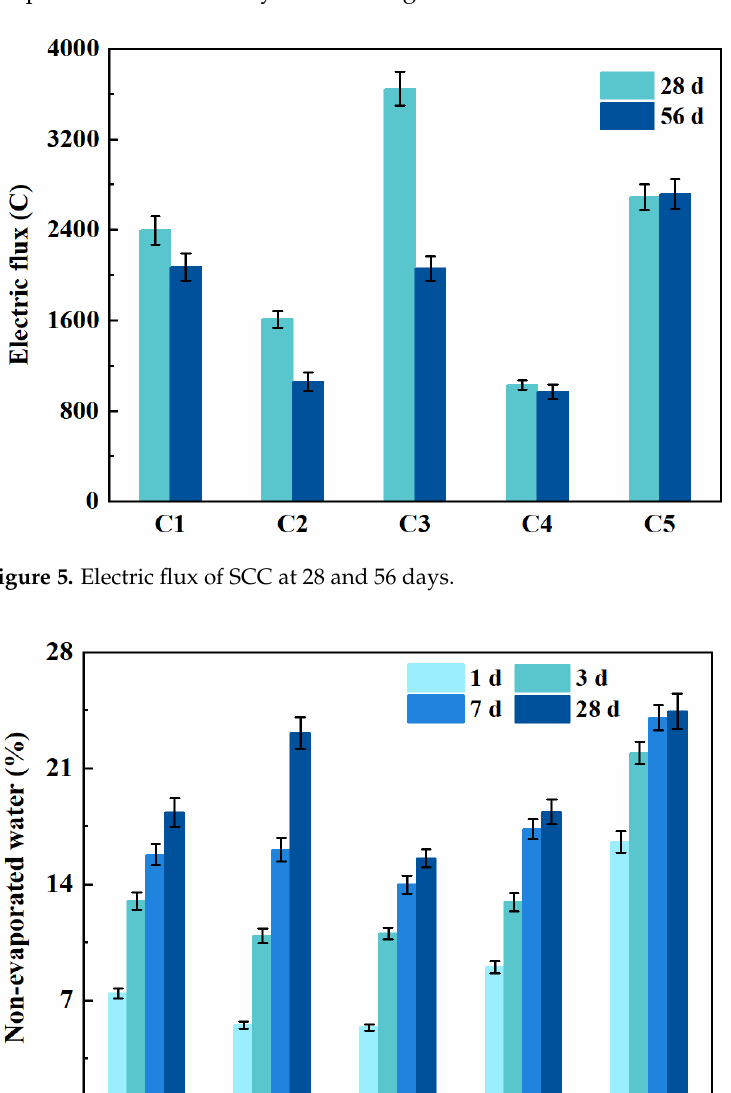
Figure 5. Electric flux of SCC at 28 and 56 days.